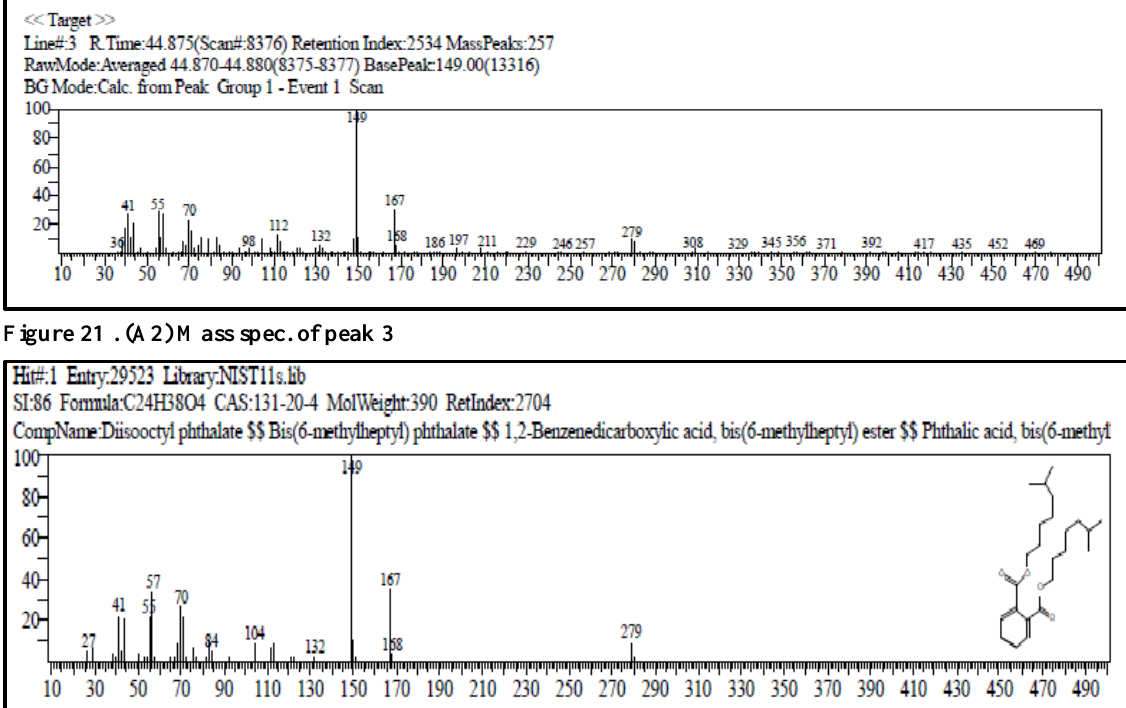
Figure 21 . (A2) Mass spec. of peak 3